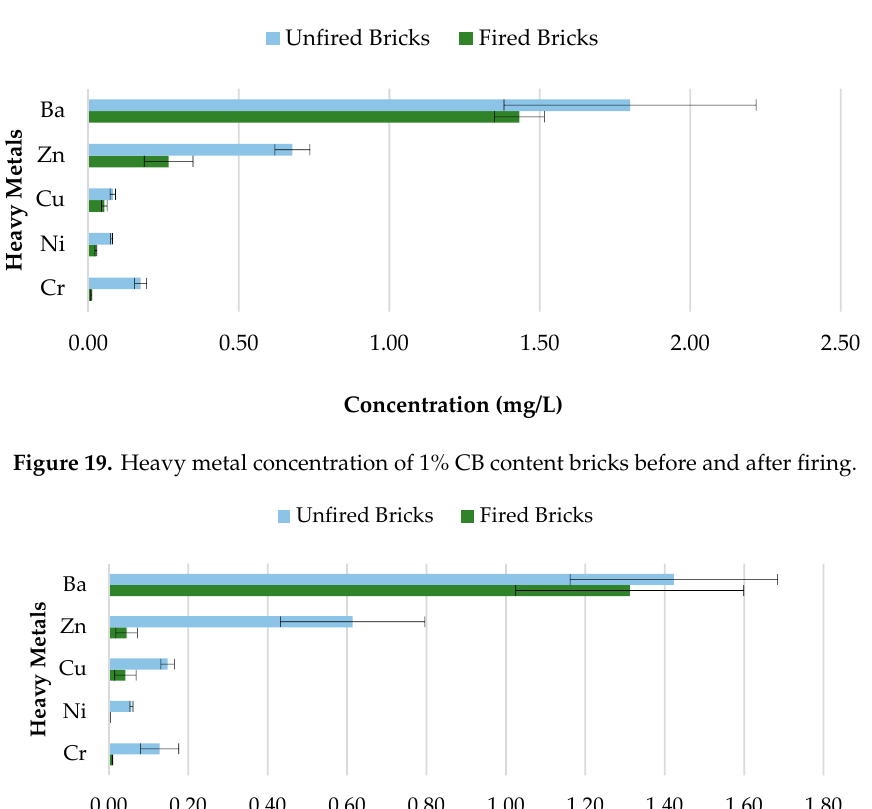
Figure 21. Heavy metal concentration of 2% CB content bricks before and after firing. The fluctuations in the leachate concentrations for unfired and fired bricks incorporating 0.5%, 1%, 1.5%, and 2% CBs by mass are summarized in Table 4. The results indicate that the addition of CBs in fired clay bricks considerably reduces the leaching ability of heavy metals. For example, the leaching of Cr and Ni was almost completely impeded after firing for bricks incorporating 0.5% and 1.5% CBs by mass. In addition, over 50% of all tested heavy metals were immobilized after firing for 0.5%, 1%, 1.5%, and 2% CB bricks. However, Ba demonstrated the least change in metal contamination after the firing process. More than 90% of Cr was immobilized in CB fired clay bricks compared to CB unfired bricks. Incorporating CBs in fired clay bricks resulted in a decrease in the metal contamination of the toxic waste, which can be an environmental advantage compared to the littering of CBs. The high firing temperature immobilized the heavy metals within the brick due to the crystalline structure of the material. To further study the leaching performance of toxic metals at various liquid to solid ratios and for compacted granular material, leaching tests can be conducted according to Method 1314 [30] and Method 1315 [31]. Although the leaching procedure followed in this study considers a wide range of pH values subject to changing environmental conditions, it does not consider leaching subject to various liquid to solid ratios and compacted granular material. However, it can be stated that fired clay bricks amended with CBs are safe under various conditions and environments as the results are significantly below the threshold limits.